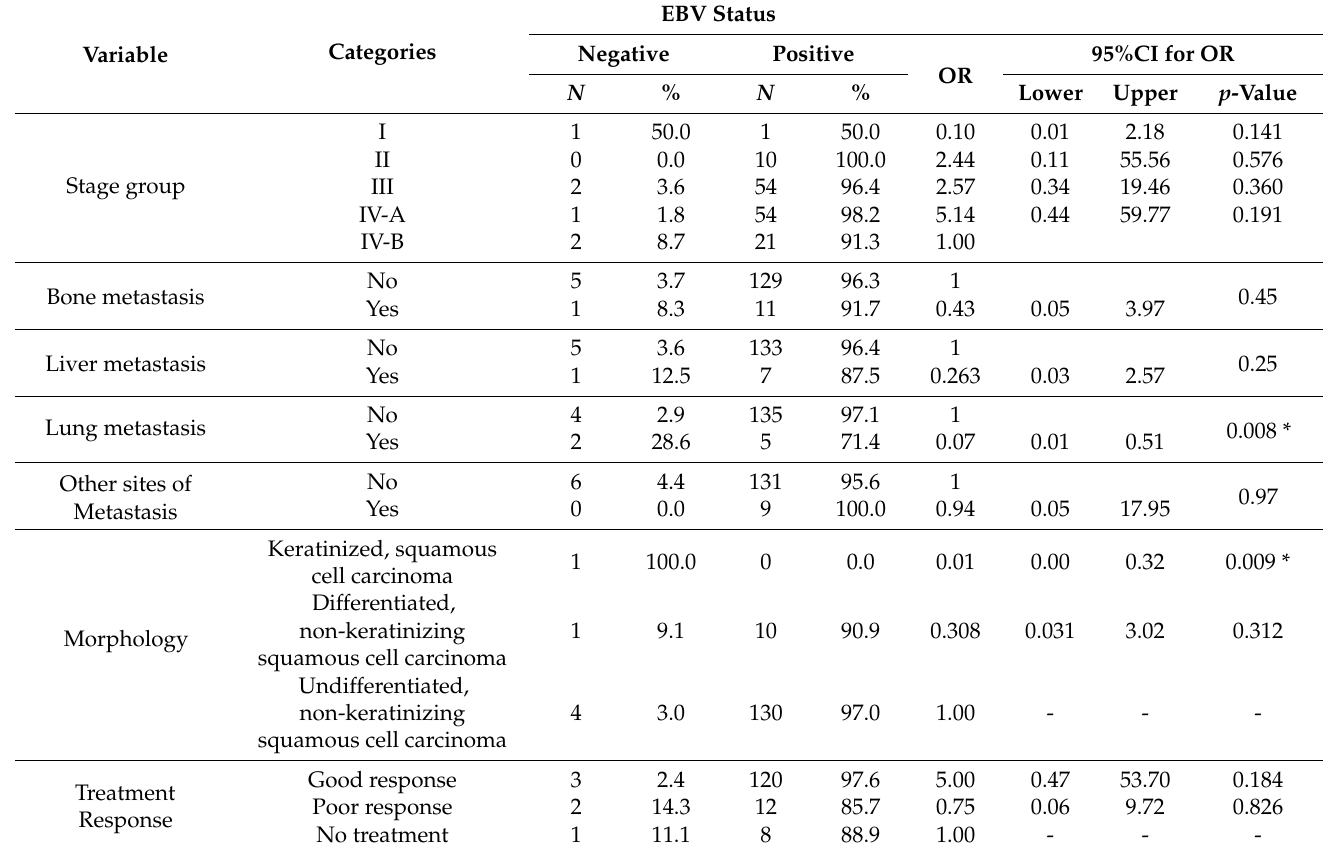
Table 4. Association between EBV status and patients’ clinical